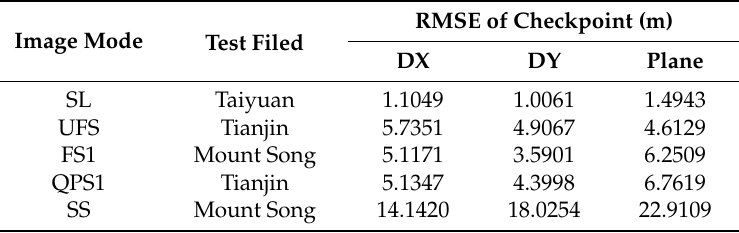
Table 4. Table of ortho-rectification accuracy comparison among the five GF-3 satellite imaging modes.